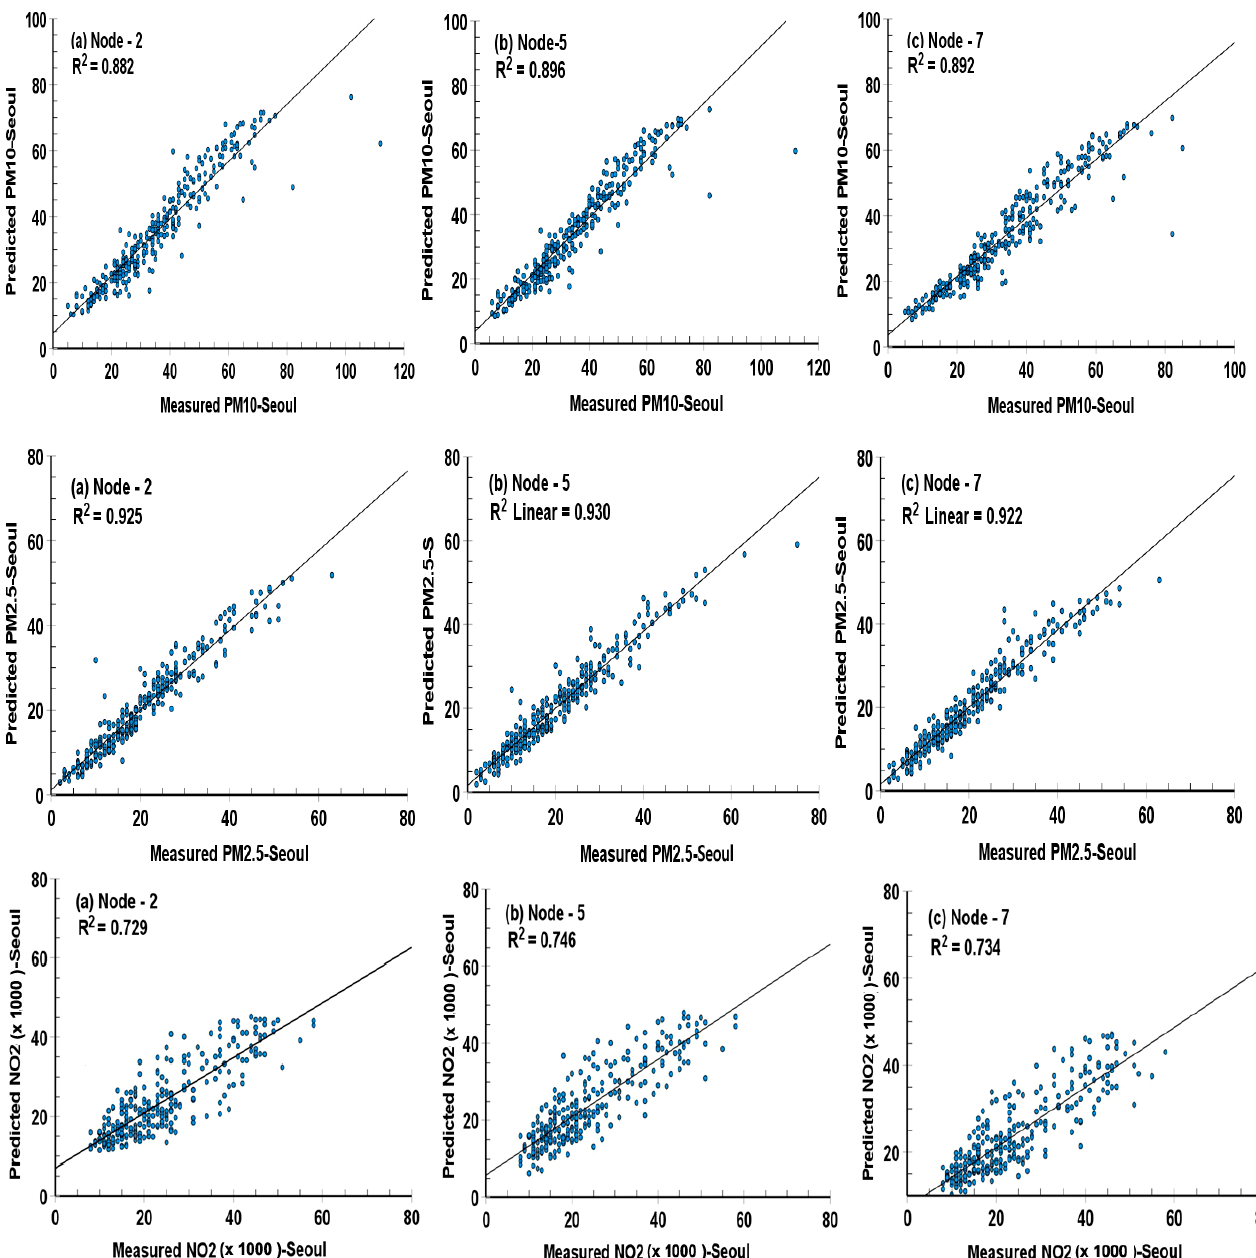
Figure 4. Scatter plots with correlations between measured and predicted daily mean concentrations of PM 10 ( μ g/m 3 ), PM 2.5 ( μ g/m 3 ), and NO 2 (ppm × 1000), using different neuron number in the hidden layer-2, 5, and 7 in an ANN, based sigmoid activation function in Seoul city, Korea during the COVID-19 epidemic year (2020).